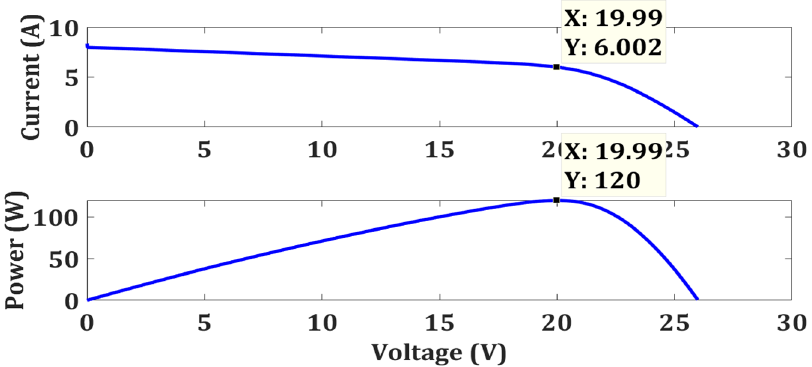
Figure 37. Characteristic curves of 2S2P PV system for test case 1 .